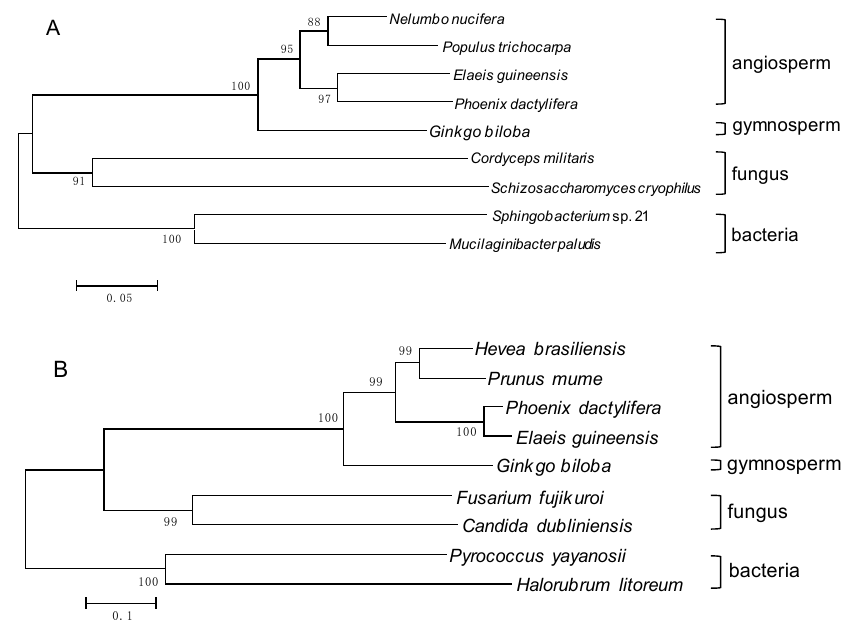
Figure 4. Phylogenetic analysis of the amino acid sequences of AACTs ( A ) and MVKs ( B ). The neighbor-